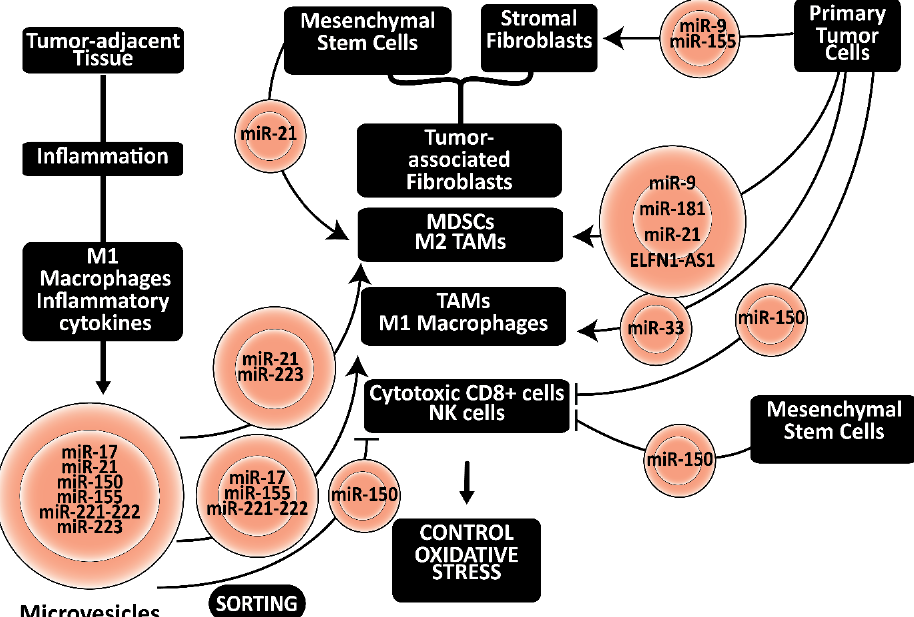
Figure 5. Exchange of noncoding RNAs by microvesicles: Mesenchymal stem cells and primary tumor cells release noncoding RNA-containing microvesicles. These noncoding RNAs control oxidative stress in the tumor environment by regulating the differentiation of fibroblasts to CAFs, and the metabolic reprogramming of T cells, MDSCs, and macrophages. In addition, noncoding RNAs in microvesicles released by inflamed tumor-adjacent tissue may affect the metabolic reprogramming of immune cells in the tumor environment. All indicated noncoding RNAs are enriched in